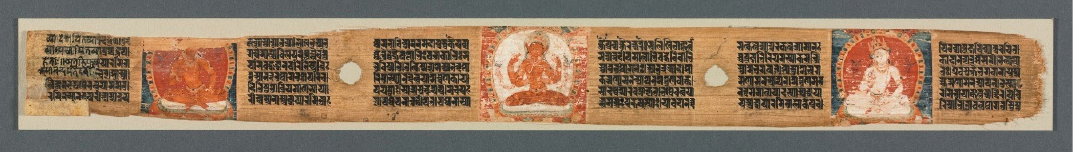
Figure 6. Preaching Amit ā bha with Avalokite ś vara (left) and Mañju ś r ī (right), fol. 186v. Perfection of Wisdom in Eight Thousand Lines: A ṣṭ as ā hasrik ā Prajñ ā p ā ramit ā -s ū tra , 1119. India and Nepal. Gum tempera and ink on palm leaf. 5.5 × 54.6 cm. Cleveland Museum of Art, purchase from the J. H. Wade Fund, 1938.301.4.